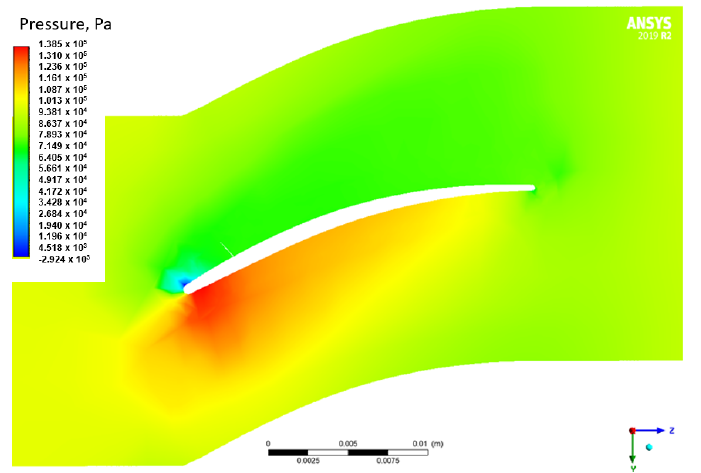
Figure 4. Relative static pressure distribution in the cross-section connecting the fluid domain for the rotational speed of 31,486 RPM (cross-section in 50% of the height of the blade − 76 mm from the axis of